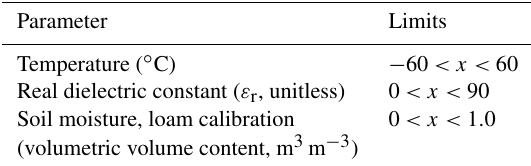
Table 2. Limits applied in QC1 – data removed. Parameter Limits